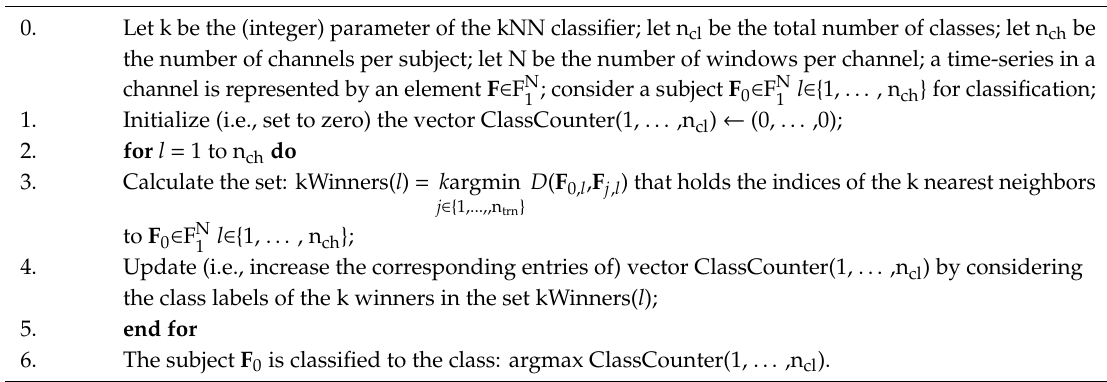
Algorithm 2 Windowed Intervals’ Number kNN (WINkNN) classifier for testing